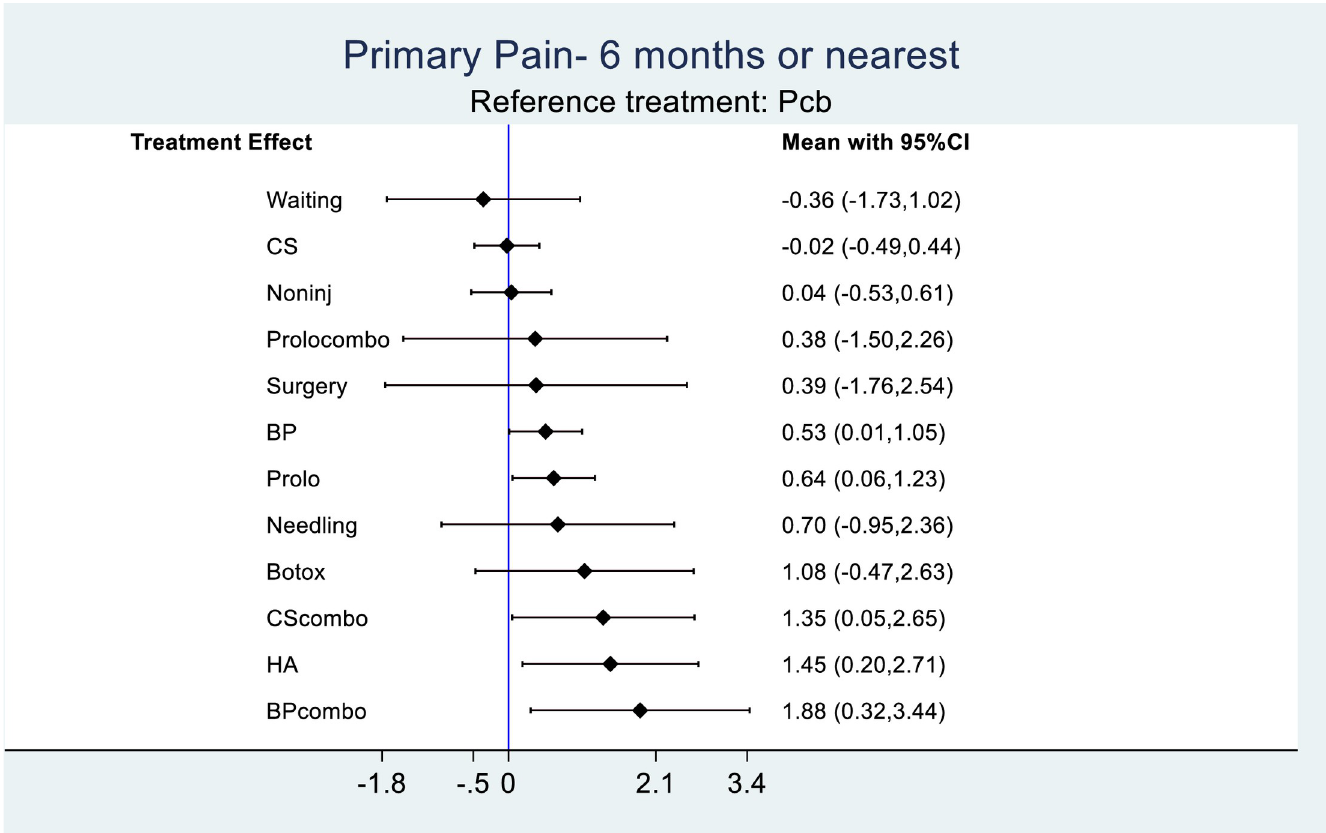
Fig 3. Interval plot of treatment efficacy relative to placebo. Note: BP = blood product; BPcombo = blood product combination therapy; Botox = botulinum toxin; CS = corticosteroid; CScombo = corticosteroid combination therapy; HA = hyaluronic acid; Noninj = non-injections; Pcb = placebo; Prolo = prolotherapy.